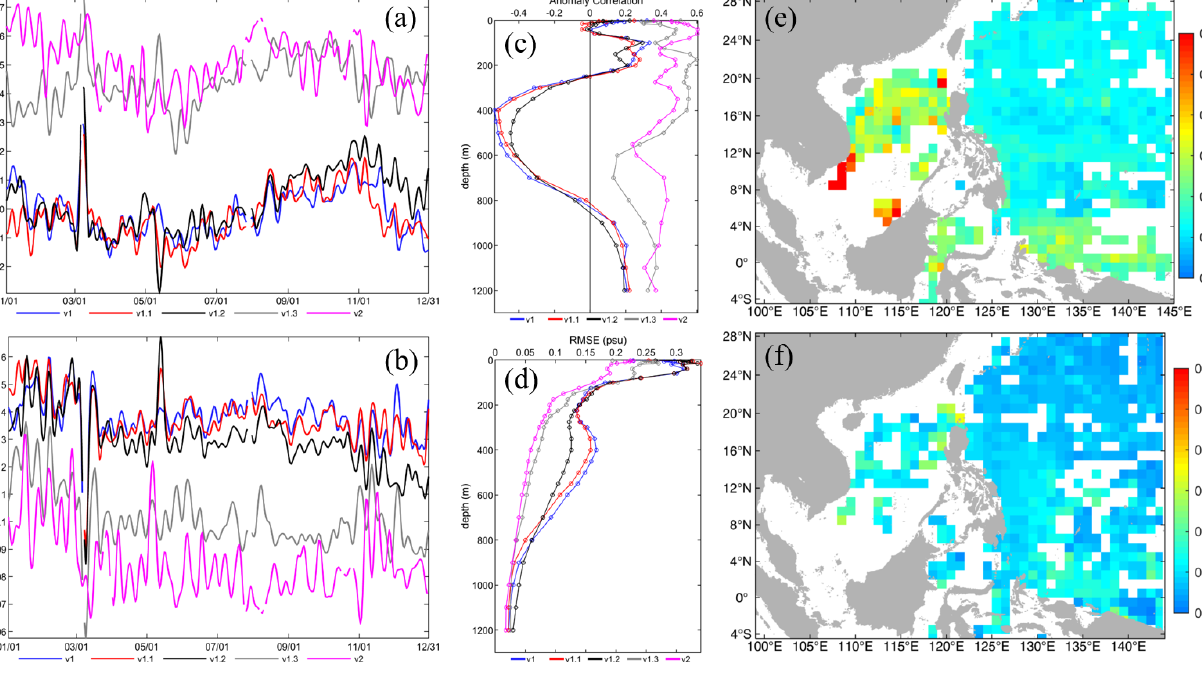
Figure 14. Similar to Fig. 13 but for salinity profile.